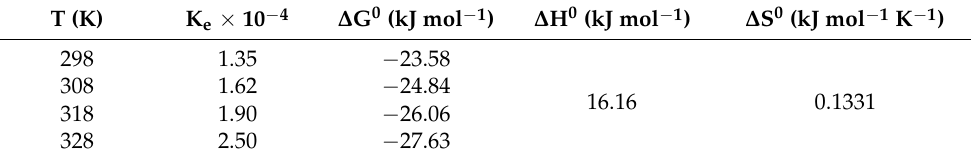
Table 2. Estimated thermodynamic parameters for the adsorption of 2,4-D in